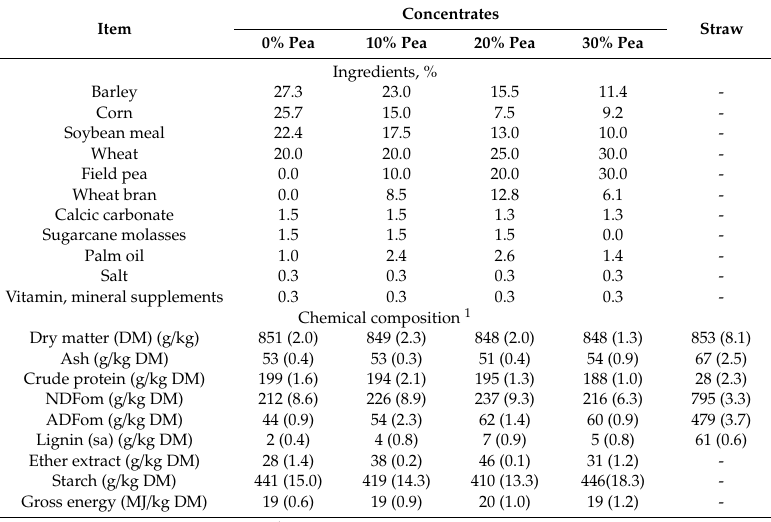
Table 1. Ingredients and chemical composition of the feedstu ff s.